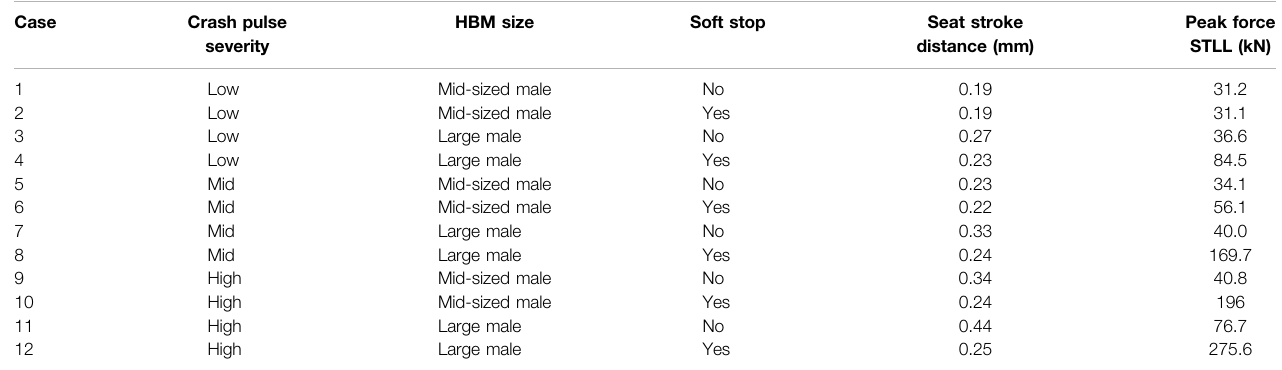
long seat stroke distances: 0.34 m for the mid-sized male in the high-severity crash pulse, and 0.33 m, and 0.44 m for the large male in mid and high-severity crash pulse, respectively.